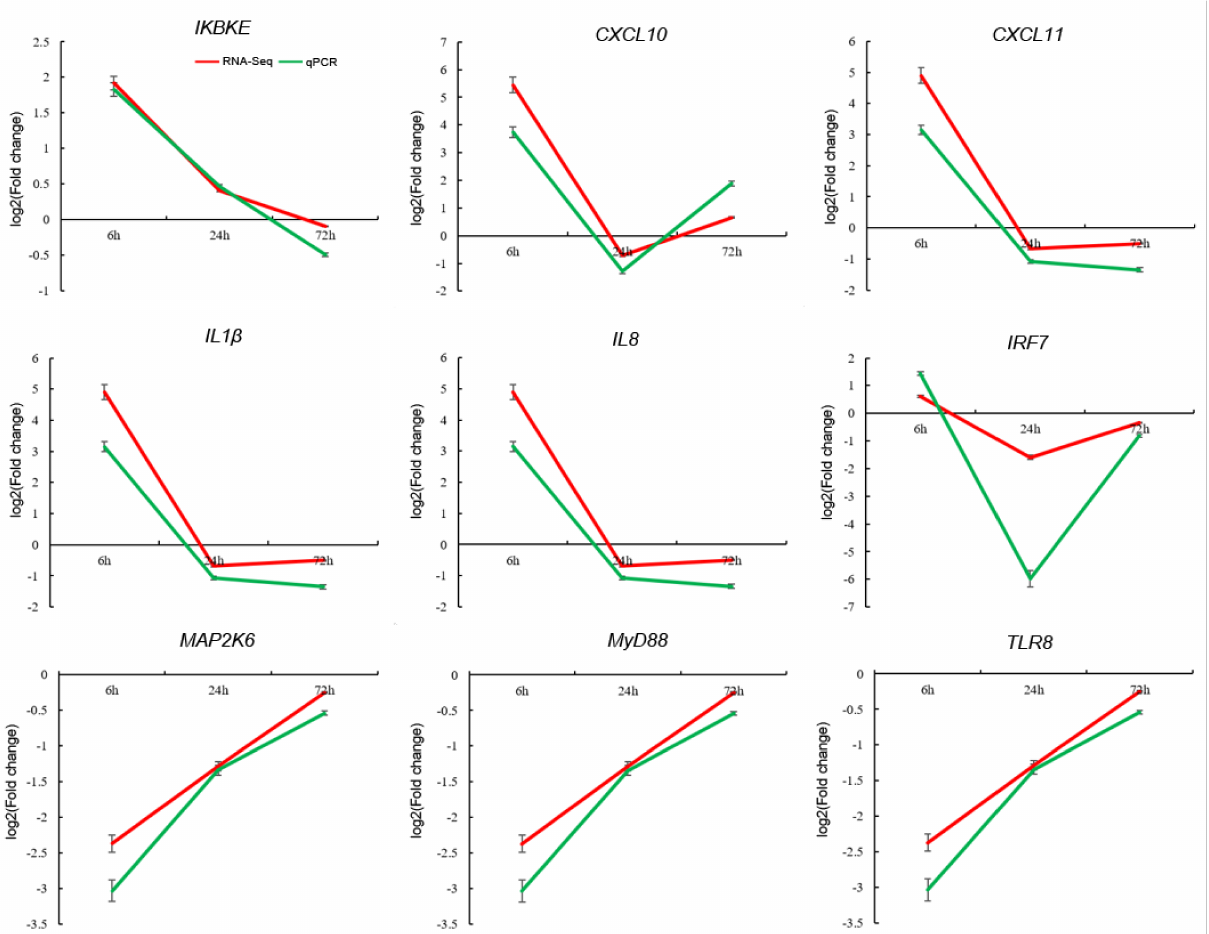
Figure 7. Validation of RNA-Seq results by qPCR. Nine DEGs are randomly selected, and the expressions of genes at different time periods are examined relative to the endogenous control genes ( β -actin and GAPDH). The relative expression values are transformed into the log 2 (fold change) form. The results are shown as the mean ± SEM of liver and spleen tissues derived from 3 individual